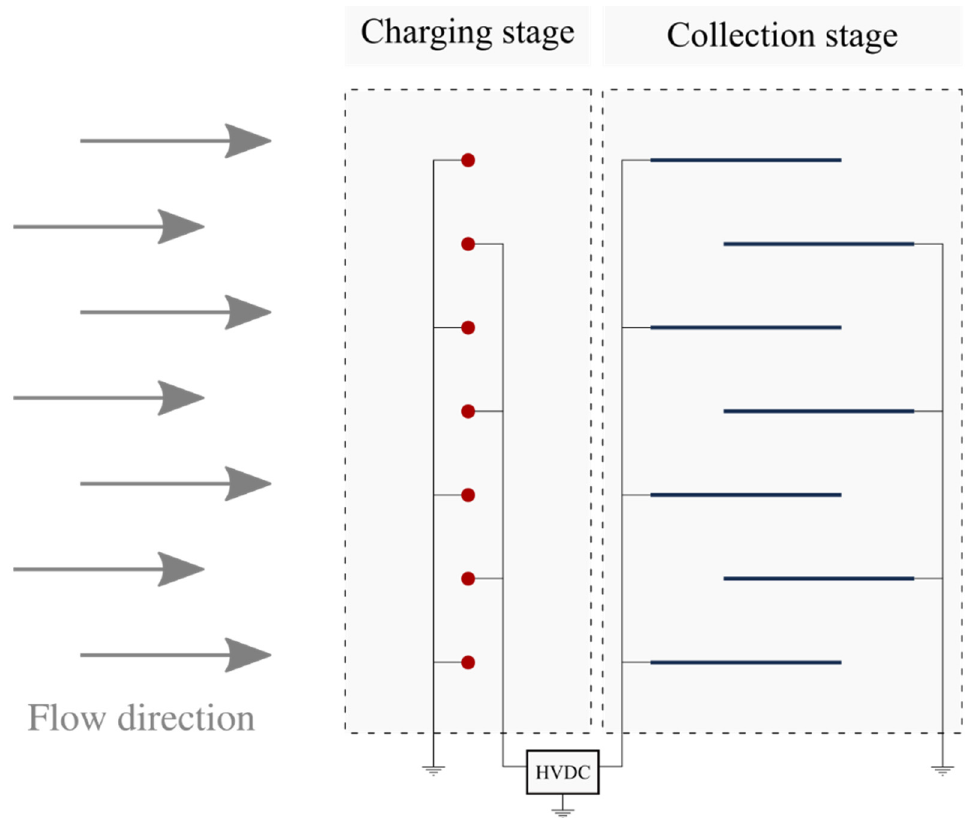
Figure 3. A typical two-stage ESP separates the charging and collection stages, which allows for increased collection efficiency and more compact packaging.